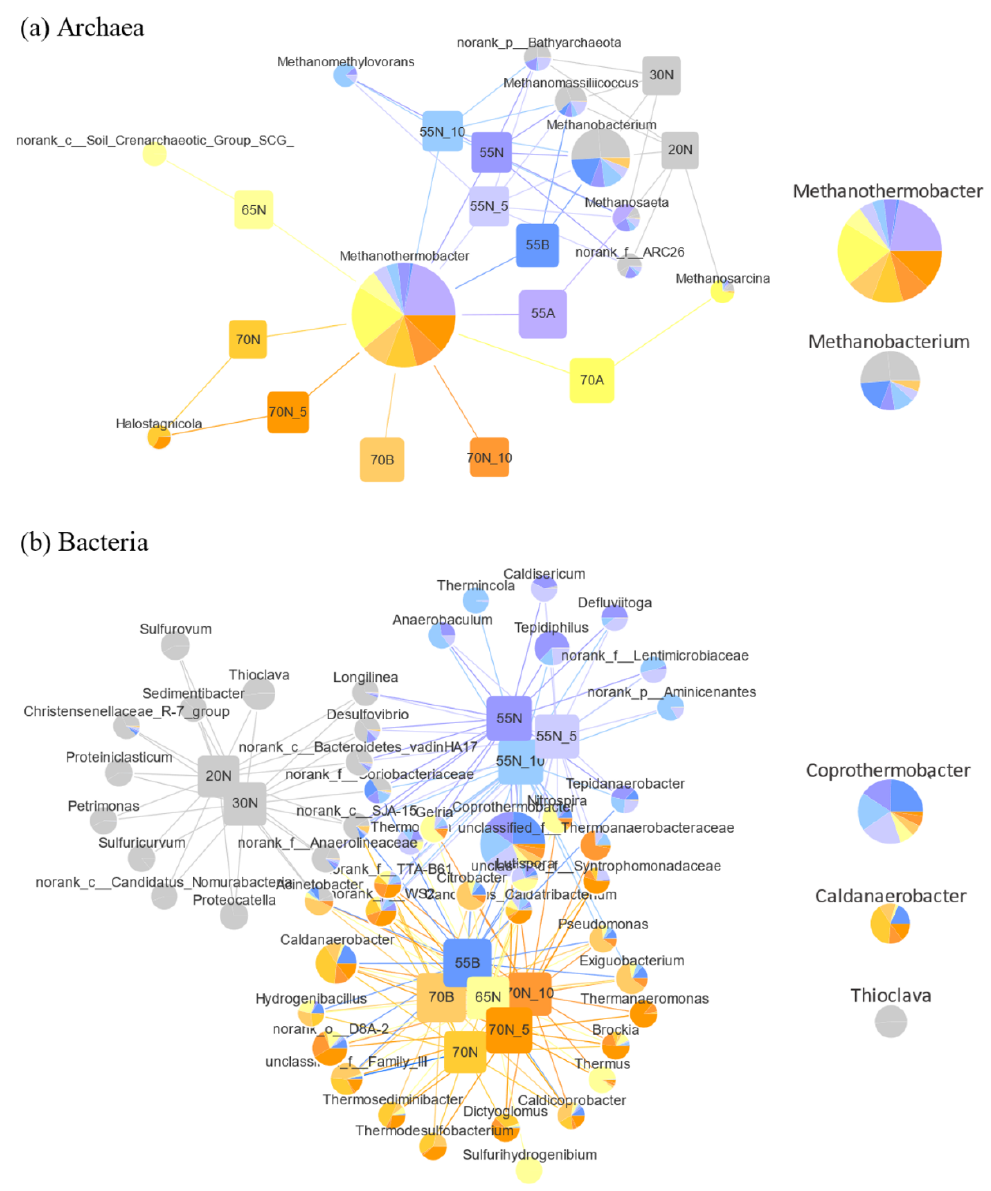
Figure 2. Profile clustering Cytoscape network visualizing microbial genera and their associations with mixed cultures: ( a ) archaea (relative abundance > 0.1%); ( b ) bacteria (relative abundance > 1%).